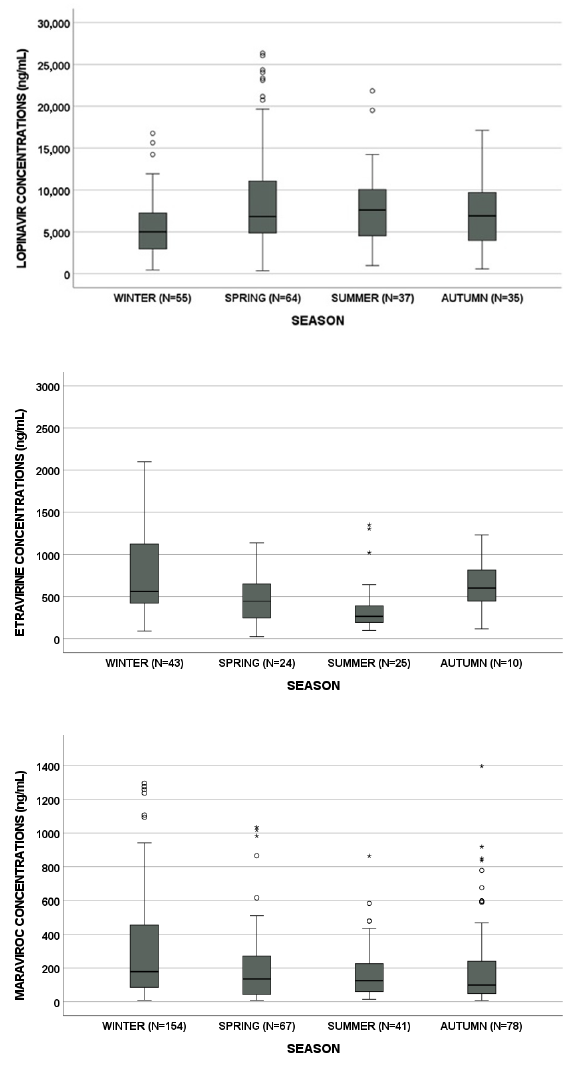
Figure 1. Lopinavir, etravirine and maraviroc concentrations according to seasonal variation. Circles and stars indicate “out” values (small circle) and “far out” values (star). Table 2. Lopinavir, etravirine and maraviroc median concentrations (ng/mL) in relation to